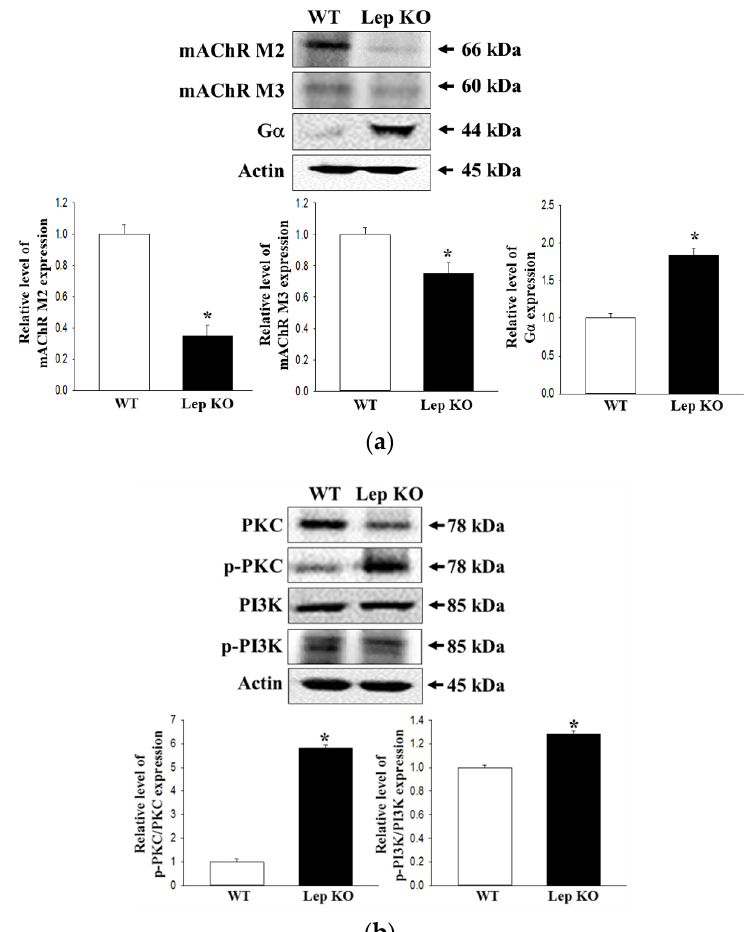
Figure 8. Expression of mAChRs and key mediators within their downstream signaling pathway. ( a ) Expression levels of mAChR M2 and mAChR M3 were measured by Western blot analysis using the specific primary antibodies and HRP-labeled anti-rabbit IgG antibody; ( b ) Expression levels of the key mediators, including G α , PKC, p-PKC, PI3K and p-PI3K, in the mAChR M2 and M3 signaling pathways, were measured by Western blot analysis using the specific primary antibodies and HRP-labeled anti-rabbit IgG antibody. After determining the intensity of each band using an imaging densitometer, the relative levels of the four proteins were calculated based on the intensity of β -actin. Three to five mice per group were used to prepare the total tissue homogenate, and Western blot analyses were assayed in duplicate in each sample. The data are reported as the mean ± SD. *, p < 0.05 compared to the WT group. Abbreviations: WT, Wild type; KO, Knockout type; mAChR, muscarinic acetylcholine receptors; PKC, Protein kinase C; PI3K, Phosphoinositide 3-kinases; HRP, Horseradish peroxidase; IgG, Immunoglobulin G.